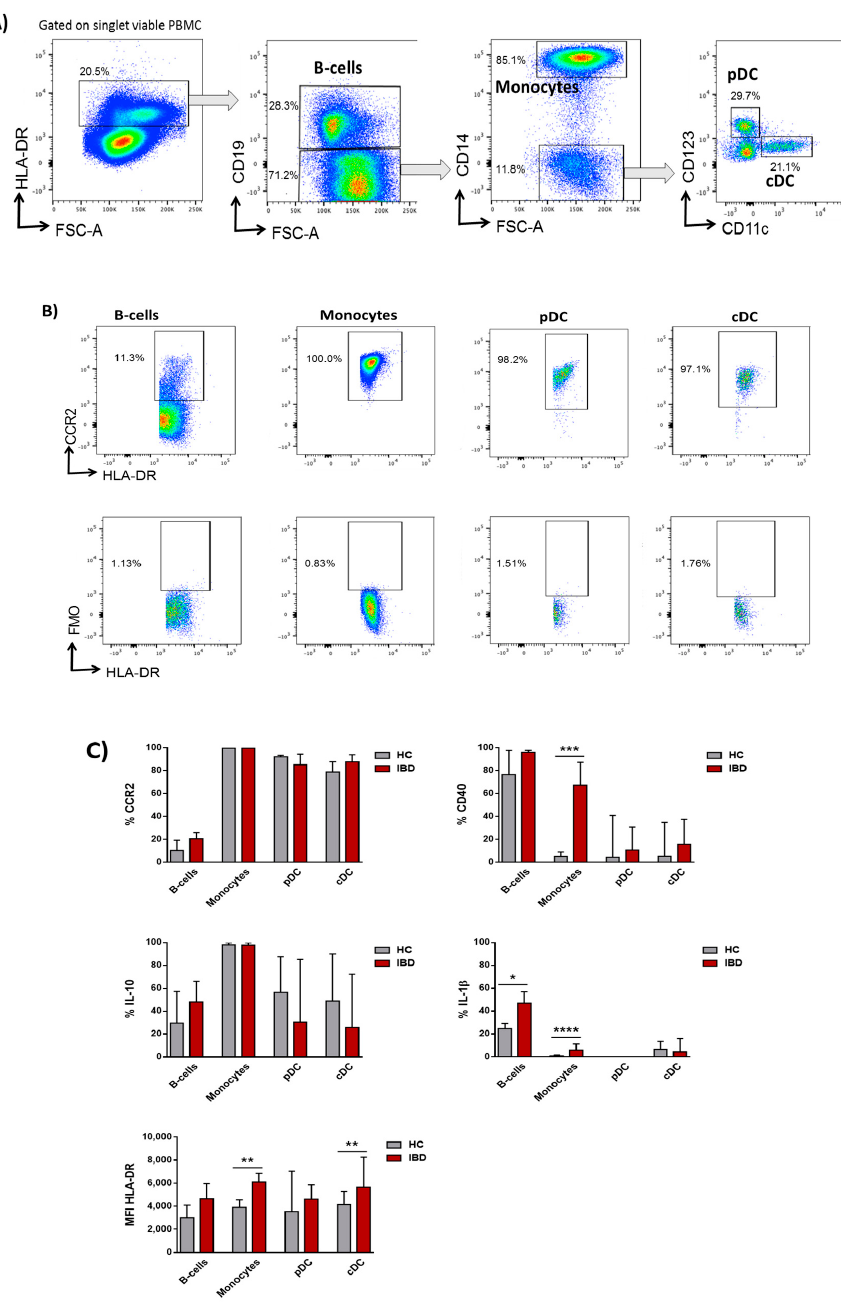
Figure 2. Circulating antigen presenting cells in healthy control and inflammatory bowel disease patients. ( A ) Human antigen presenting cells (APCs) were identified by flow cytometry within singlet viable peripheral blood mononuclear cells (PBMCs) as HLA-DR + . APCs were further divided into B-cells (CD19 + ), monocytes (CD19 − , CD14 + ), plasmacytoid dendritic cells (pDCs) (CD19 − , CD14 − , CD123 + , CD11c − ), and conventional dendritic cells (cDCs) (CD19 − , CD14 − , CD123 − , CD11c + ). ( B ) APC subsets were further characterized for the expression of CCR2, CD40, IL-10, and IL-1 β by the fluorescence minus one (FMO) method, as in the example. ( C ) Phenotype of human B-cells, monocytes, pDCs, and cDCs from healthy controls (HCs) and inflammatory bowel disease (IBD) patients based on the basal expression of CCR2, CD40, IL-10, IL-1 β , and HLA-DR. Results are expressed as percentage of positive cells (%) for CCR2, CD40, IL-10, and IL-1 β or by the median fluorescence intensity (MFI) for HLA-DR in each given subset. The Mann–Whitney test was applied to compare the basal expression of CCR2, CD40, IL-10, IL-1 β , and HLA-DR within each subset between HC and IBD patients. p -values < 0.05 were considered significant (* < 0.05, ** < 0.01, *** < 0.001, **** <